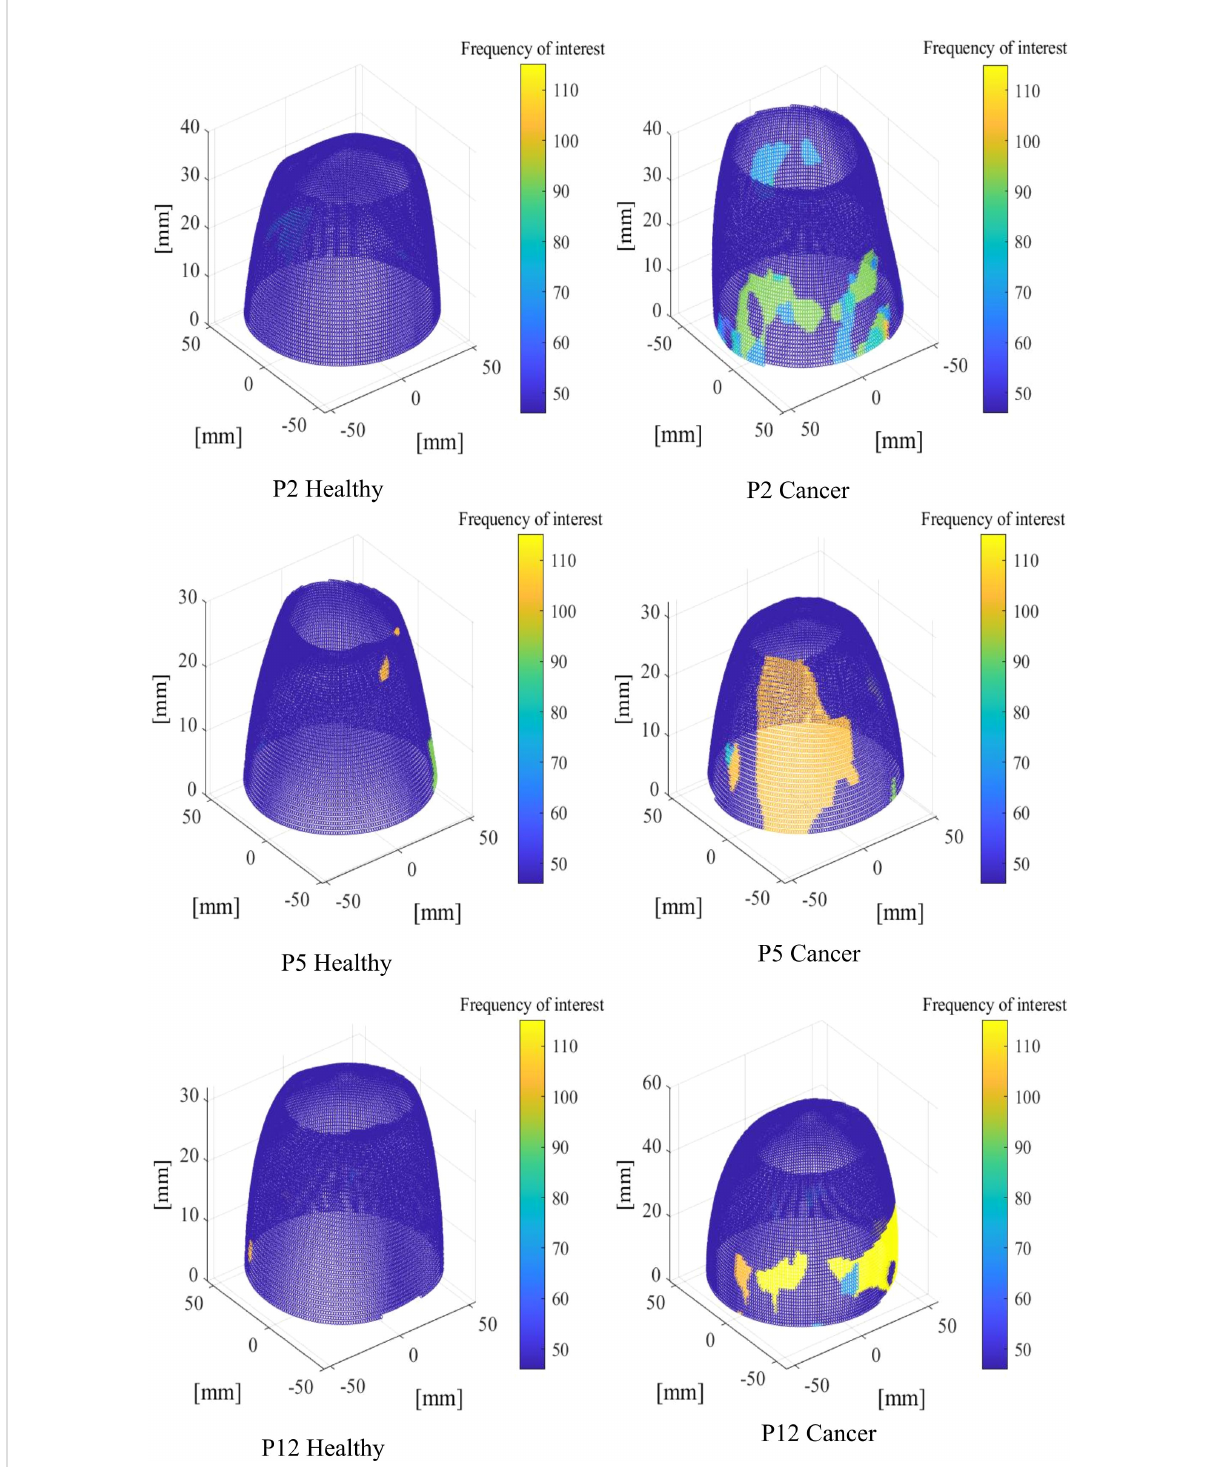
FIGURE 5 Three-dimensional (3D) plots showing areas of high frequency of interest for healthy (left) and cancerous (right) breasts at input frequency, fe=23